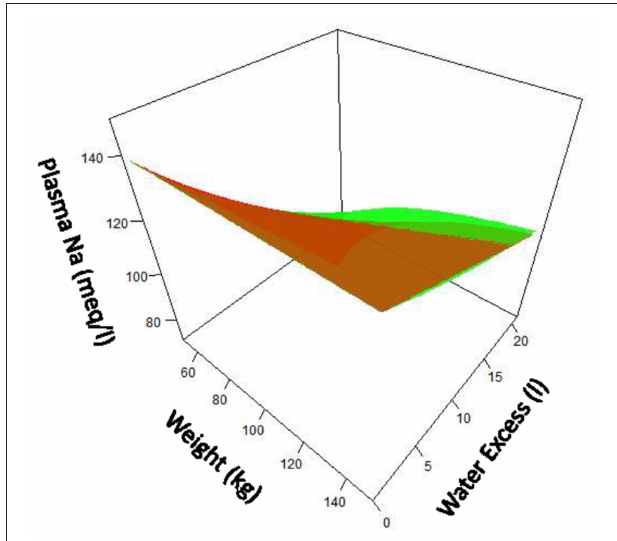
FIGURE 2 | Comparison of “simple” formula (green) for serum sodium compared with Edelman formula (red) over ranges of patient size and water excess. Assumption made that fraction of water is 0.6 X body weight. Note that at lower patient size and greater water excess, difference between two formula becomes